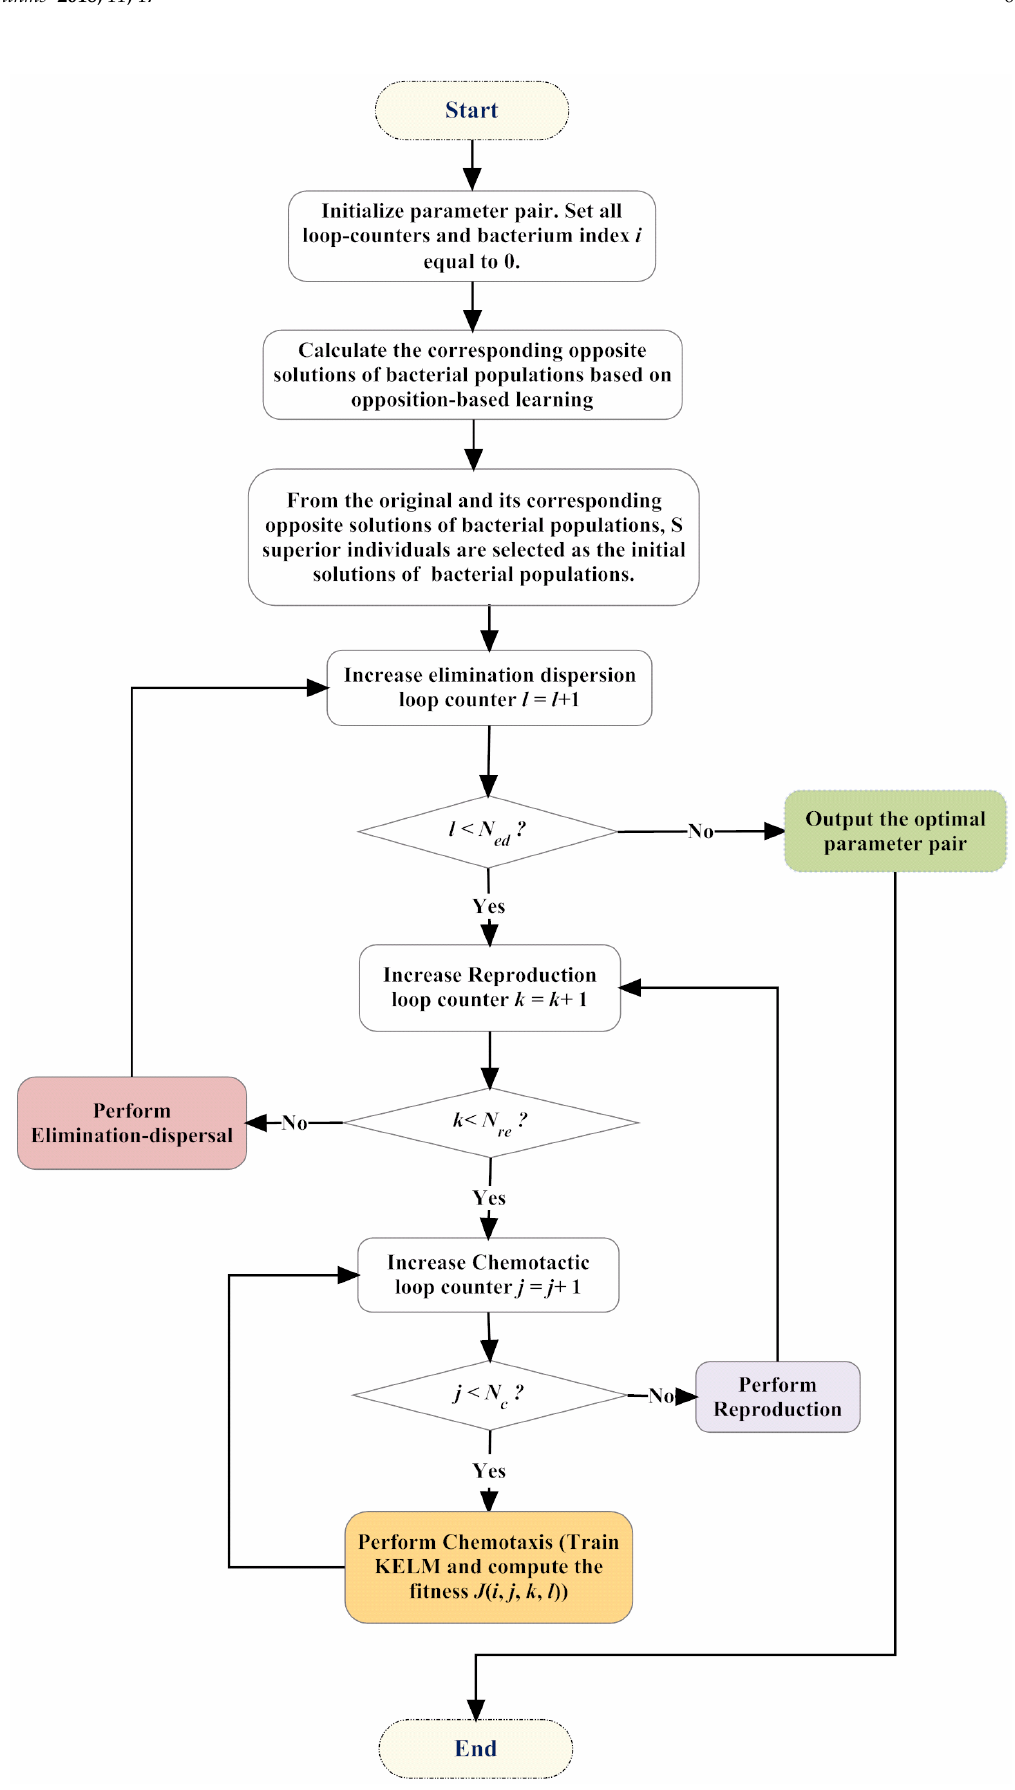
Figure 1. Flowchart of the improved bacterial foraging optimization strategy